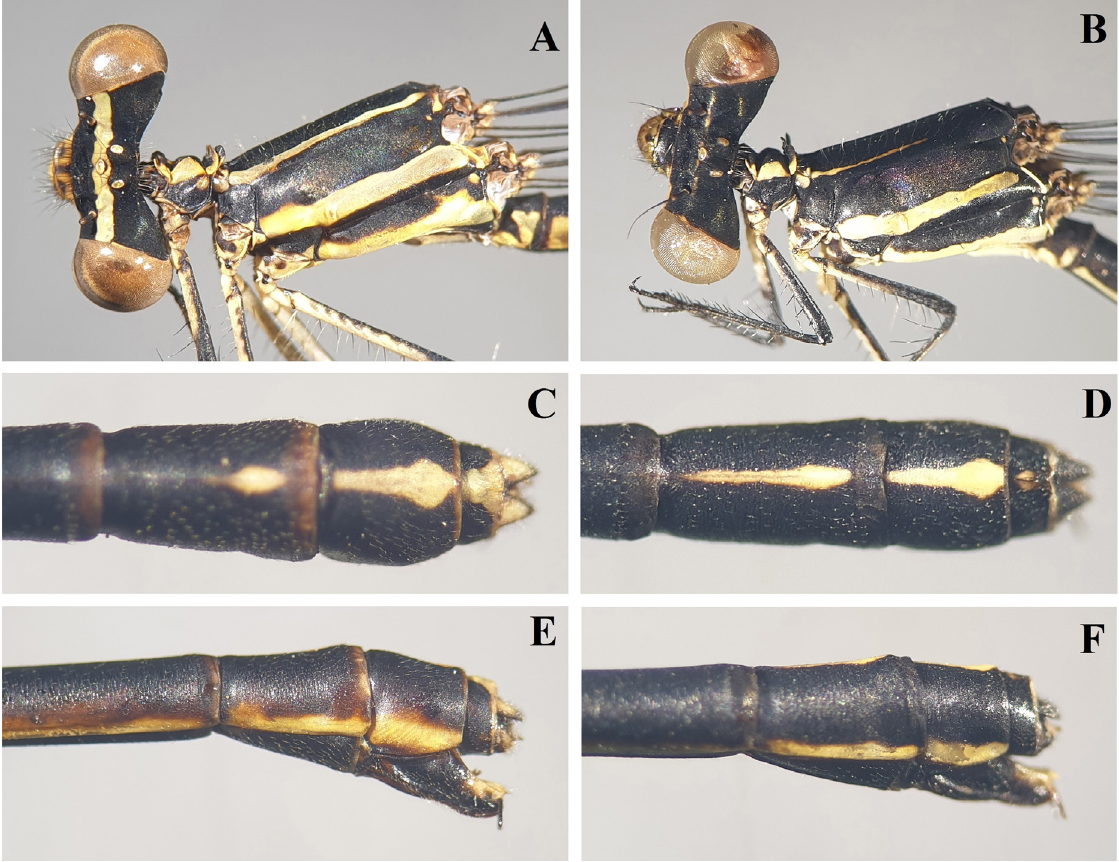
Fig. 11. Prodasineura Cowley, 1934 spp., female paratypes. A, C, E . P. kong sp. nov., ZCDTU 2019071817-ODO. B, D, F . P. lancastrei sp. nov., ZCDTU 2019051217-ODO. A–B = head and thorax, lateral view; C–D = abdominal tip, dorsal view; E–F = abdominal tip, lateral view. Images not to